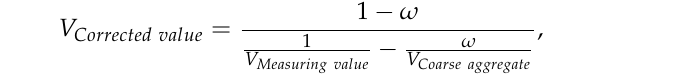
Table 7. Correction value of the UPV values after removing the effect of coarse aggregate (m/s).